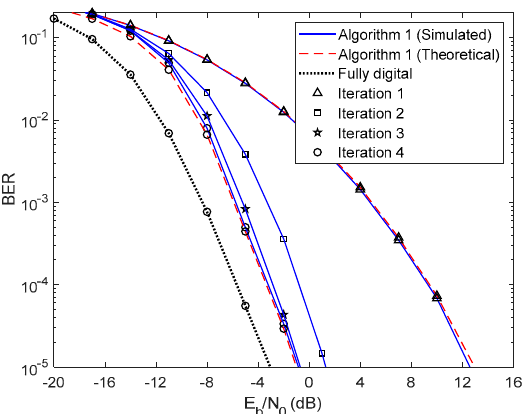
Figure 3. Performance of the proposed hybrid iterative multi-user equalizer (Algorithm 1) for the NCSI precoder with ULA configuration and QPSK modulation.